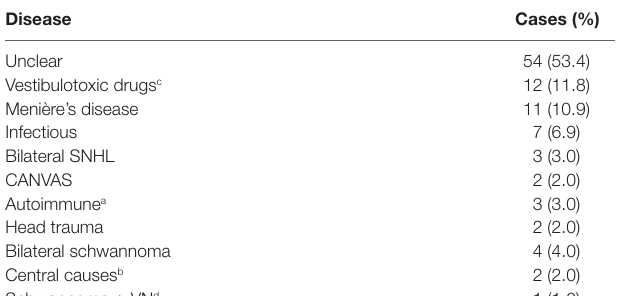
TaBle 1 | Diagnostic criteria for impairment of the semicircular canals (SCCs) and the otolith